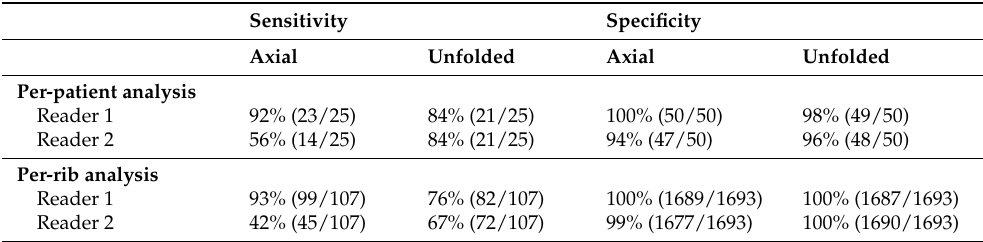
Table 2. Diagnostic accuracy on a per-patient and per-rib basis, not considering repeated measure- ments. Values given are sensitivity/specificity with the absolute numbers in parentheses.